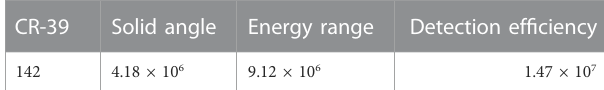
TABLE 1 The correct number of α